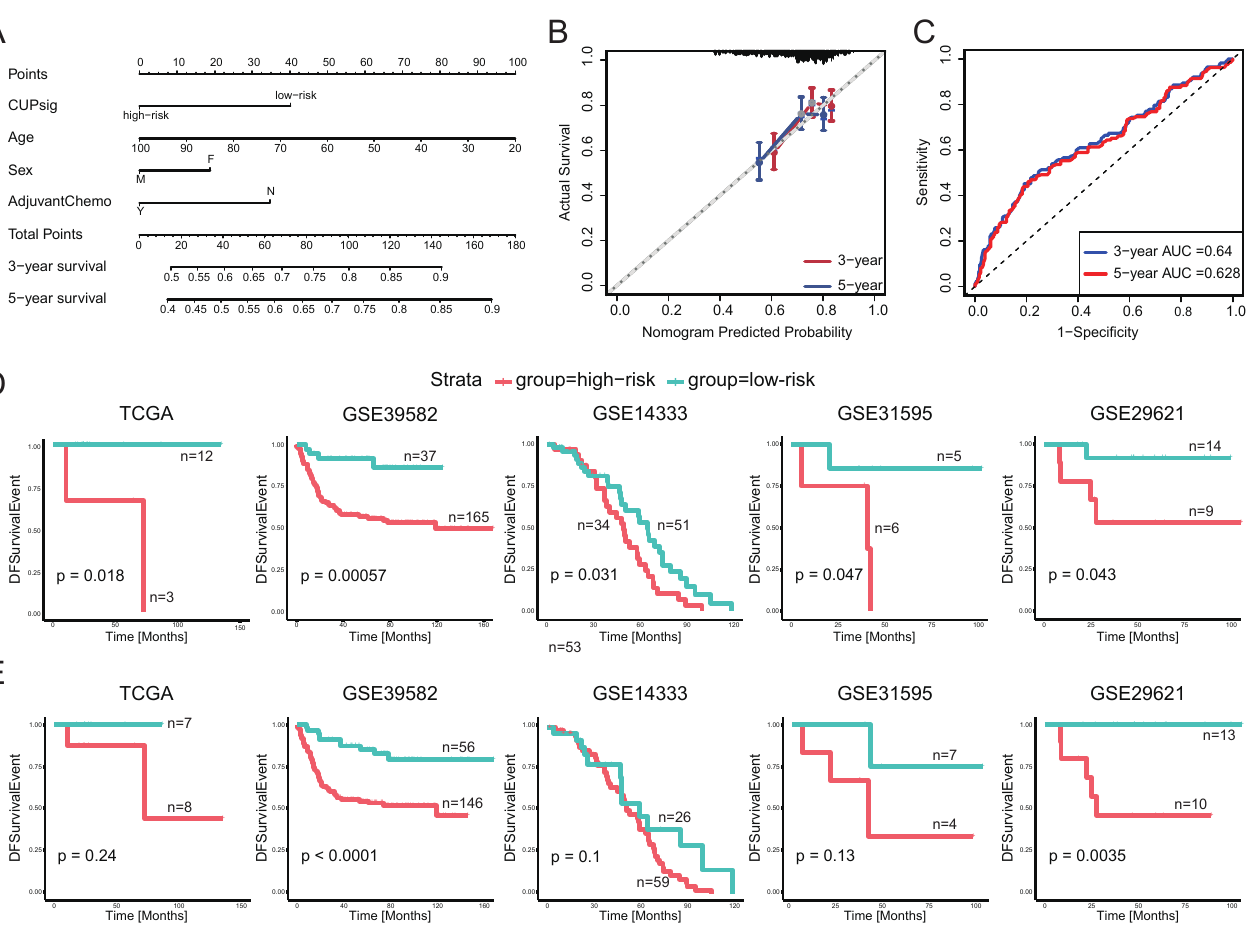
Figure 4. ( A – C ) Nomogram, calibration curve, and the AUC of nomogram model based on ROC curve used to predict the disease-free survival time of patients with stage II–III CRC in GSE39582: ( A ) nomogram, ( B ) calibration curve, ( C ) ROC curve. ( D , E ) Evaluation of the predictive power of CUPsig and CDPsig in stage II–III CRC patients receiving adjuvant chemotherapy. Kaplan–Meier survival curves of DFS in high-risk and low-risk patients with stage II–III CRC in the five drug-treated validation datasets (TCGA-5FU-based, GSE39582-5FU-based, GSE14333-5FU-based, GSE29621-5FU- based, and GSE31595-drug-unknown), while other seven datasets without adjuvant chemotherapy information were not used: ( D ) CUPsig, ( E )